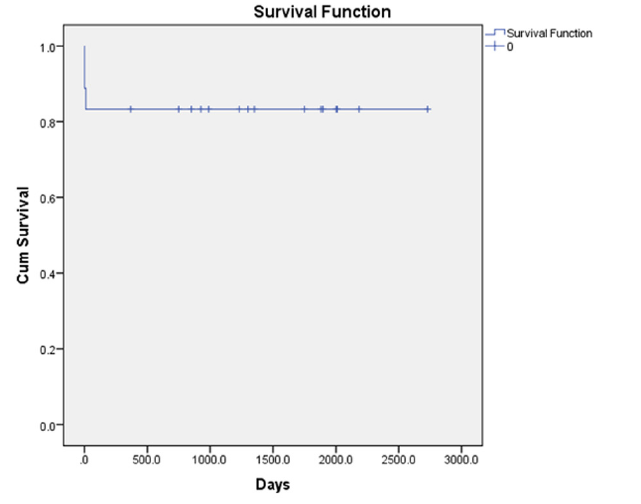
Fig. 3 - Survival analysis presented in Kaplan-Meier